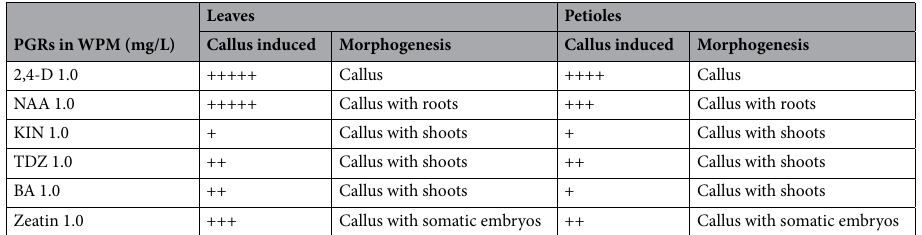
Table 1. Effects of different PGRs on callus induction (after 6 weeks) and morphogenesis (after two months) from leaf and petiole explants of Euryodendron excelsum . *Shoot proliferation and subculture on WPM supplemented with 1.0 mg/L BA and 0.2 mg/L NAA once every two months. Each treatment had 30 explants. For the treatment WPM with 1.0 mg/L 2,4-D, the number of explants was 180. + indicates a crude estimate of a relative amount of callus, ranging from sparse (+) to profuse (+++++).